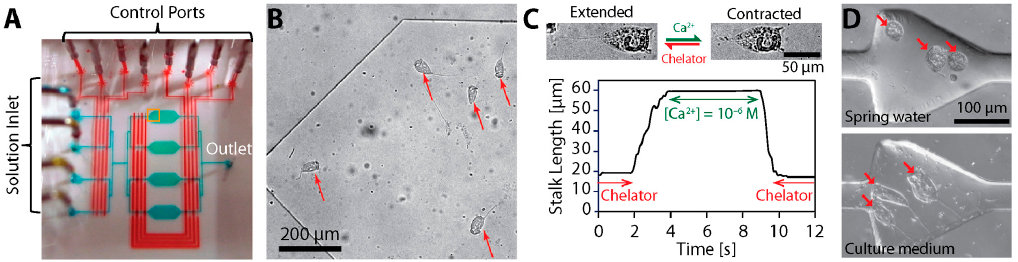
Figure 13. V. convallaria in a microfluidic system. ( A ) Microfluidic device for chemical control of extracted V. convallaria ; ( B ) V. convallaria cells cultured in the device; ( C ) length change in a Vorticella stalk in a different [Ca 2+ ] free (A–C reproduced from [145]); ( D ) V. convallaria cells in a single chamber of which the size is comparable to the size of the cell (reproduced from [144]).